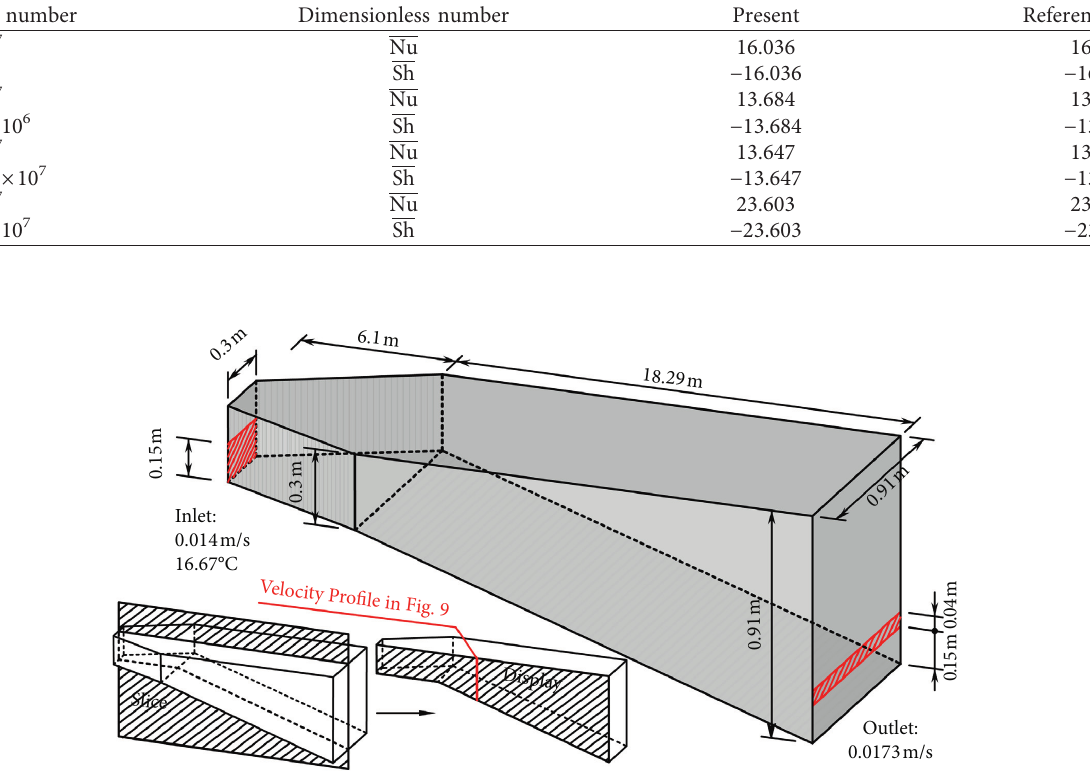
Table 1: Comparison of average Nusselt number and average Sherwood number along the hot